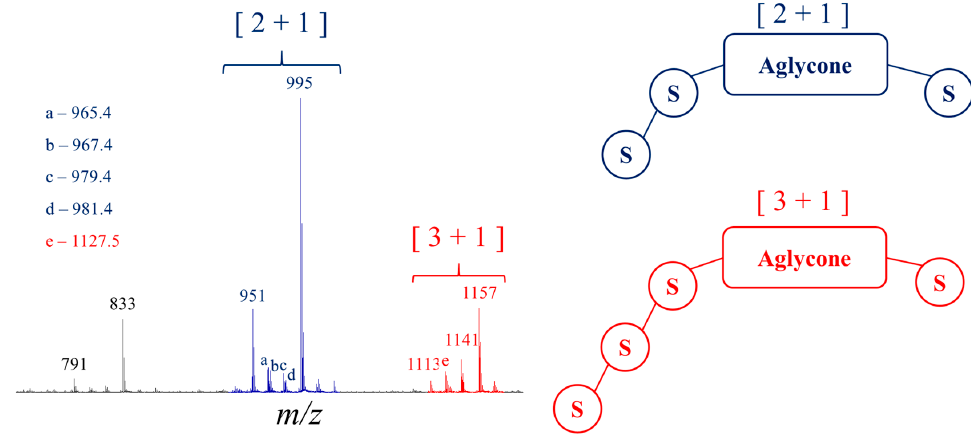
Figure 4. Mass spectrometry analysis of the quinoa saponin extract: MALDI-MS (+) spectrum (DHB/DMA as the matrix) and schematic representation of the [2 + 1] and [3 + 1] saponin structures. Ions detected at m / z 791 and 833 are fragment ions from the intact saponin ions. This is demonstrated using LC-MS analysis as shown in the SI.